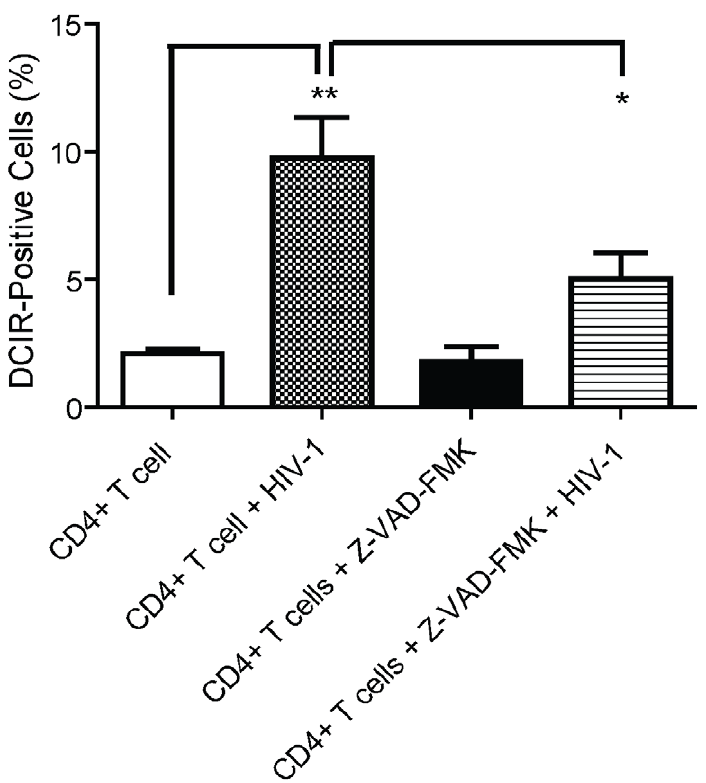
Figure 4. Virus-mediated induction of DCIR is partly prevented by a caspase inhibitor. Mitogen-activated CD4 + T cells (1 6 10 6 ) were first either left untreated or treated for 1 h with the caspase inhibitor Z-VAD-FMK (50 nM), after which HIV-1 was added (100 ng of p24), where indicated. DCIR expression was monitored 3 days later by flow cytometry. Data shown represent the means 6 SD of triplicate samples from three independent experiments. Asterisks denote statistically significant data (*, P , 0.05; **, P ,